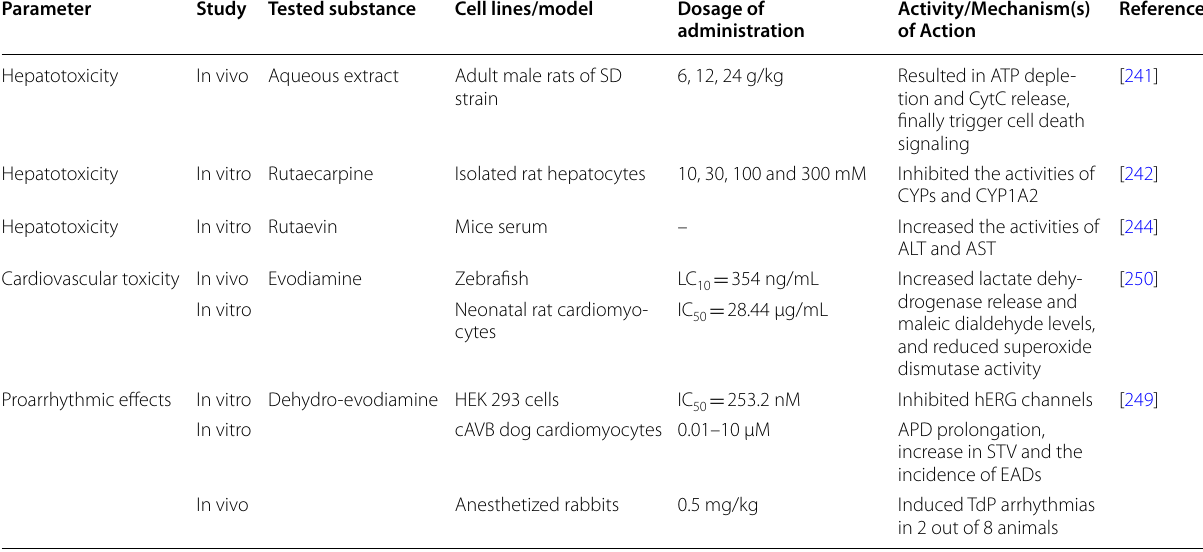
Table 5 Toxicity of Euodiae Fructus and its constituents